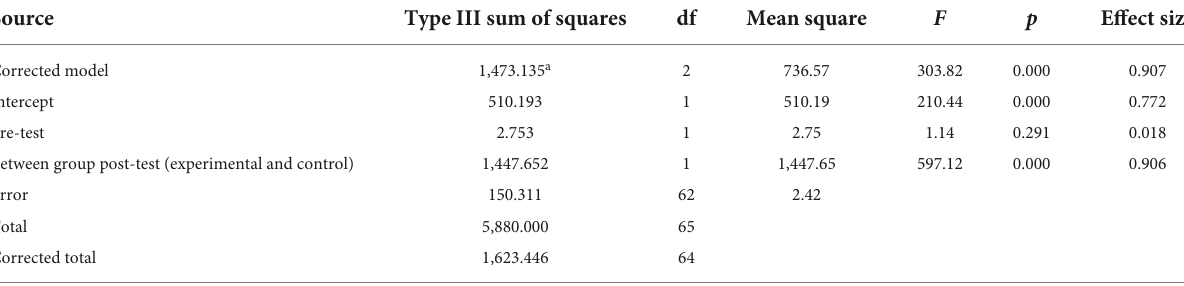
TABLE 4 Analysis of covariance (ANCOVA) result on students’ ability to write coherent paragraph in composition writing after exposure to concept mapping instruction. Source